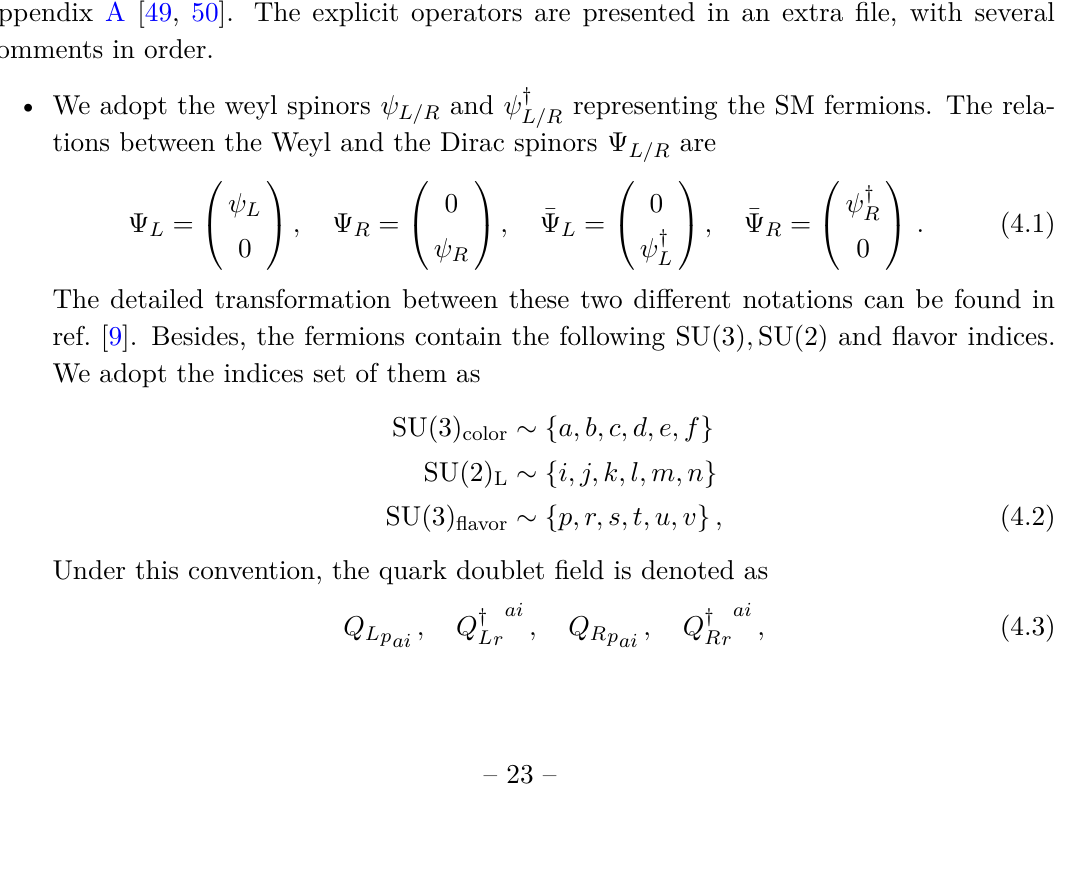
Table 3 . The numbers of the NNLO operators in each